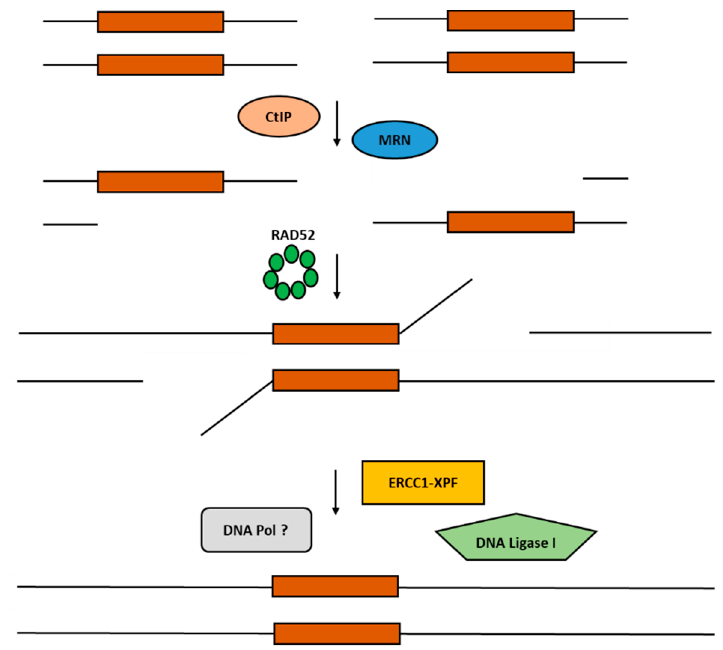
Figure 1. Schematic representation of the RAD52-mediated SSA DNA repair mechanism. RAD52 facilitates homology search and strand annealing.